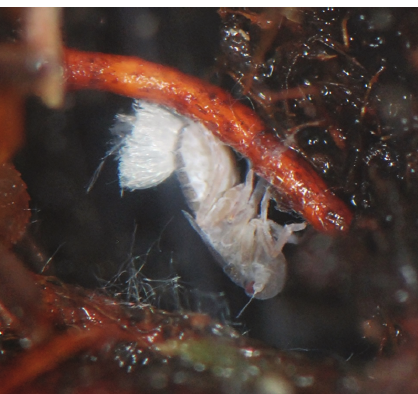
Figure 2: Fifth instar C. meridionalis nymph feeding on a root of Empetrum nigrum in a terrarium.